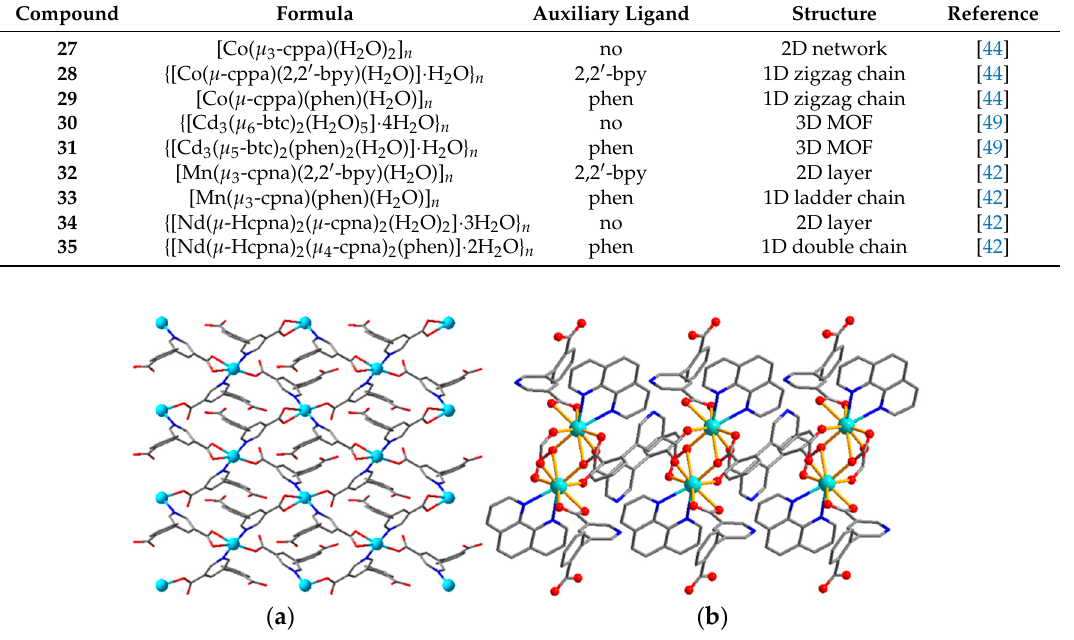
Table 5. Selected examples of CPs showing an effect of auxiliary ligand on product structure. Compound Formula